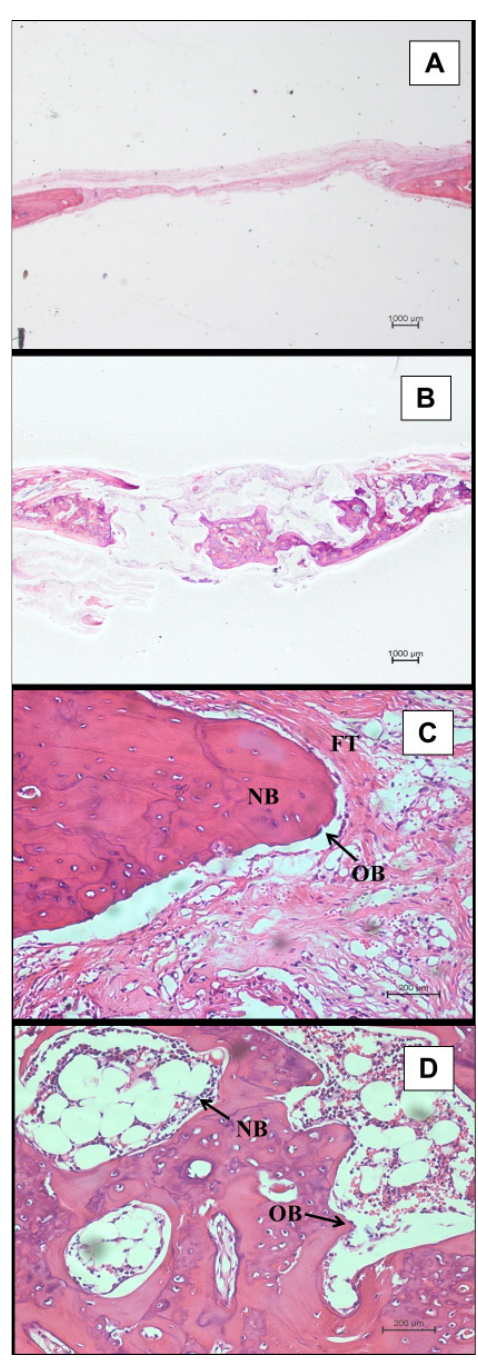
Figure 6. Histological alterations 12 weeks after scaffold implantation. Light microscopy (HE) of the critical size calvarial defect at control (empty defect) and scaffold-treated (PLDLA construct) implants. (A) Control site filled with thin fibrous connective tissue. (B) Bone formation in the center of the implant. (C) Presence of active osteoblasts (OB) around newly formed bone at the margin of a defect implanted with a PLDLA scaffold. Note the presence of fibrous tissue (FT) at the interface between new bone (NB) and space of implanted PLDLA. (D) New bone (NB) in a defect implanted with a PLDLA scaffold. Note the inflammatory reaction (arrow) and active osteoblasts (OB) surrounding the remaining polymeric fragments